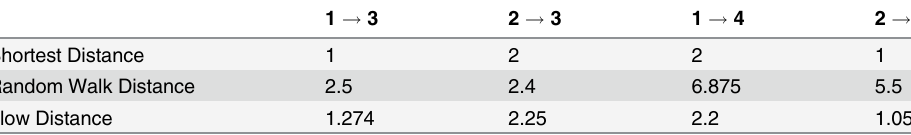
Table 1. The comparisons between flow distances and other well-known